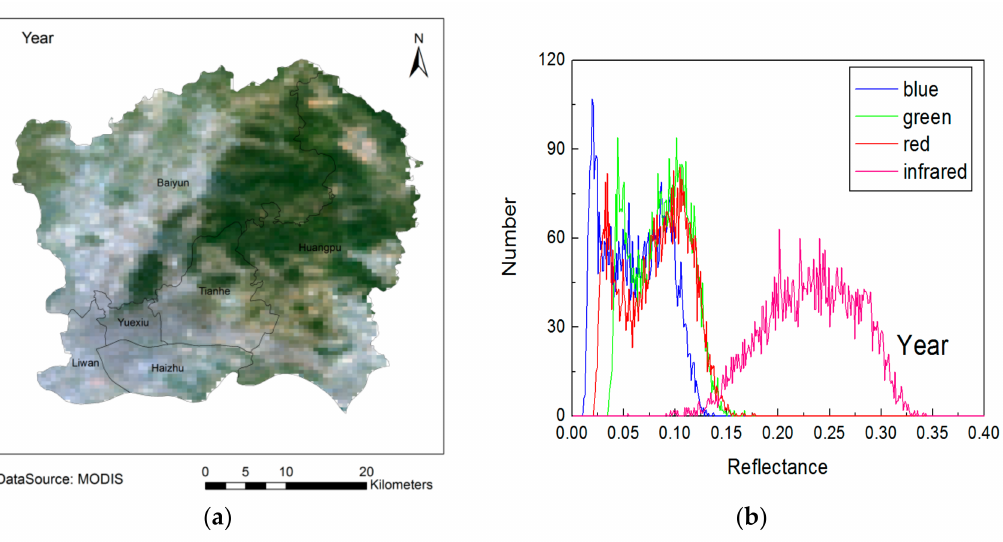
Figure 5. Surface reflectance ( a ) and histogram ( b ) for